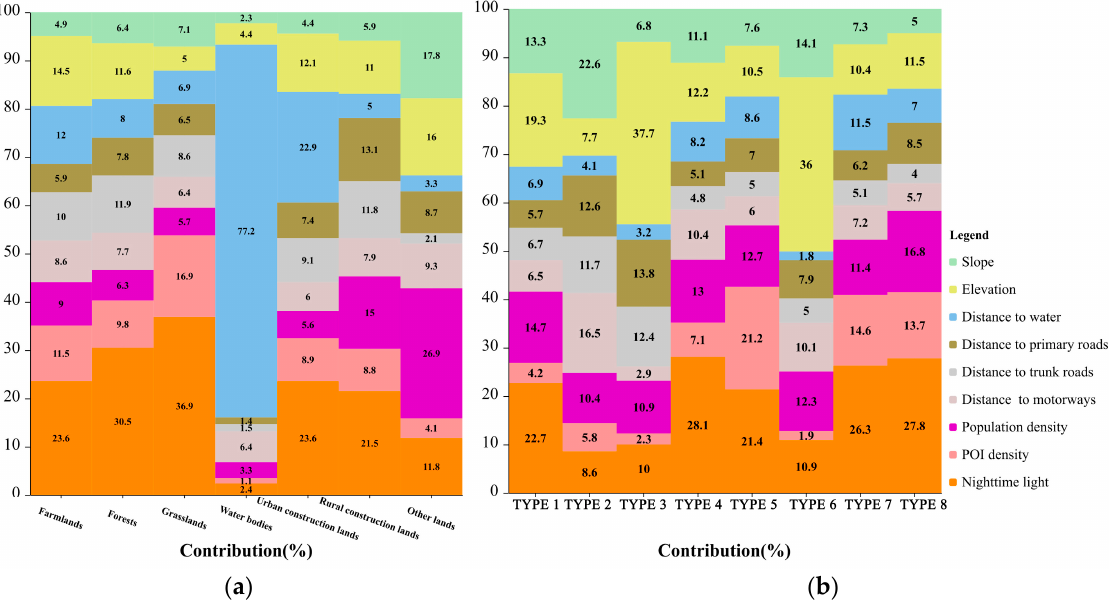
Figure 9. Contribution of the driving factors to ( a ) land-use conversion, and ( b ) LCT change.